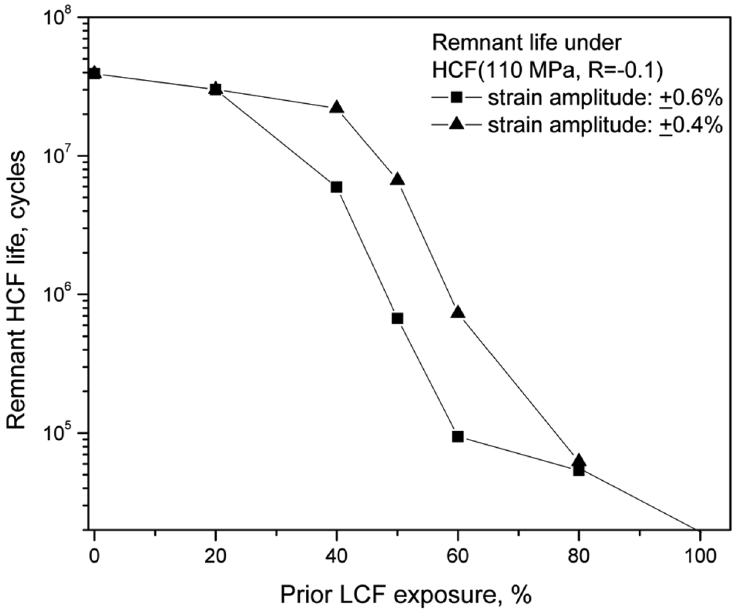
Fig. 2: Variation of remnant HCF lives with increase in prior LCF exposure (%)